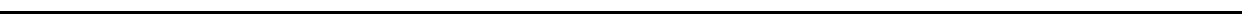
Fig. 5 BL001 promotes beta and alpha cell mass expansion in immunized RIP-B7.1 mice. The control (C) mass of beta ( a , b ) and alpha cells ( c , d ) of RIP- B7.1 mice was decreased after immunization (IMN), an alteration that was prevented by 10 mg/kg b.w. BL001 daily treatment for 8 weeks (BL IMN). Dot plots show the results from 8 (4 weeks) and 16 (8 weeks) pancreas per group, each dot corresponding to the cell mass of an entire pancreatic section. e – j Representative immuno fl uorescence images of islets co-stained and quanti fi ed for e , f insulin (INS, red) and Ki67 (green), g , h insulin (red) and Tunel (green), i , j glucagon (GLUC, red) and Ki67 (green). All values are means of 5 mice per group. Scale bars: 25 µ M. Right panels are enlargements of boxed area, and arrow heads point to example of cells simultaneously stained for 2 proteins. k Representative confocal images showing the distribution of the insulin- (red) and glucagon-bihormonal cells (green) as well as l quanti fi cation in islets of the different animal groups. Nuclei were stained with DAPI (blue). Scale bar: 25 µ M. Right panel show enlargements of boxed areas. Arrow heads point to cells co-stained for the two depicted markers. m A representative image depicting co-immunostaining of PDX1 (red) and glucagon (green) in a pancreas of a normoglycemic immunized BL001-treated mouse, and n quanti fi cation of such cells in the various groups. Bottom left panels are enlargements of boxed area. Bottom right panels, are without DAPI staining. White arrows point to PDX1 + /GLUC + cells, # identi fi es a PDX1 - /GLUC + cell and * highlights a PDX1 + /GLUC - cell. n = 15 pancreatic slices obtained from fi ve independent mice per group. Scale bar: 25 µ M. o After a 24-h exposure to 10 μ M BL001 (BL), alpha TC-1.6 cells featured decreased expression of the Arx, glucagon (Ggc) and MafB transcripts. Six independent experiments were performed and subsequent QT-PCR conducted in triplicates. Values are means + s.e.m. ( f , h , j , l , n , o ). * p < 0.05, ** p < 0.01, *** p < 0.001, and **** p < 0.0001, one-way ANOVA ( a – d , f , h , j , l , n ) and the Student ’ s t test as compared to control ( o